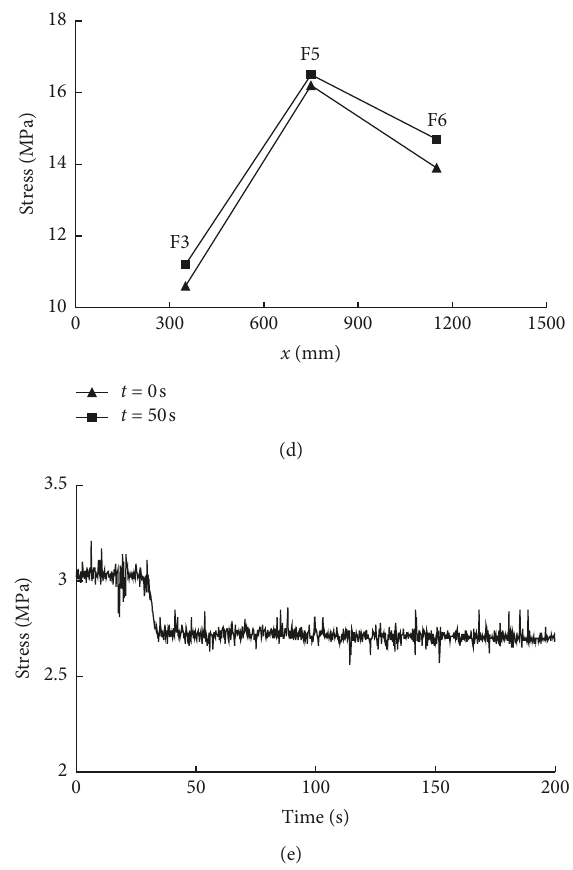
Figure 6: Variation characteristics of gas pressure during coal and gas outburst. (a) Arrangement of stress sensors. (b) Sensor F5. (c) Sensor F6. (d) Sensors F3, F5, and F6 (along the X -axis direction). (e) Sensor F12.